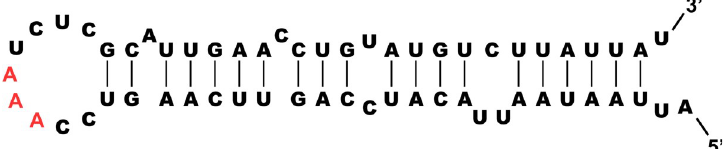
Fig 2. Predicted secondary structure of the cis-acting replicating element of EV-D111. The triplet known to be directly involved in the uridylation of the protein 3B is in red.